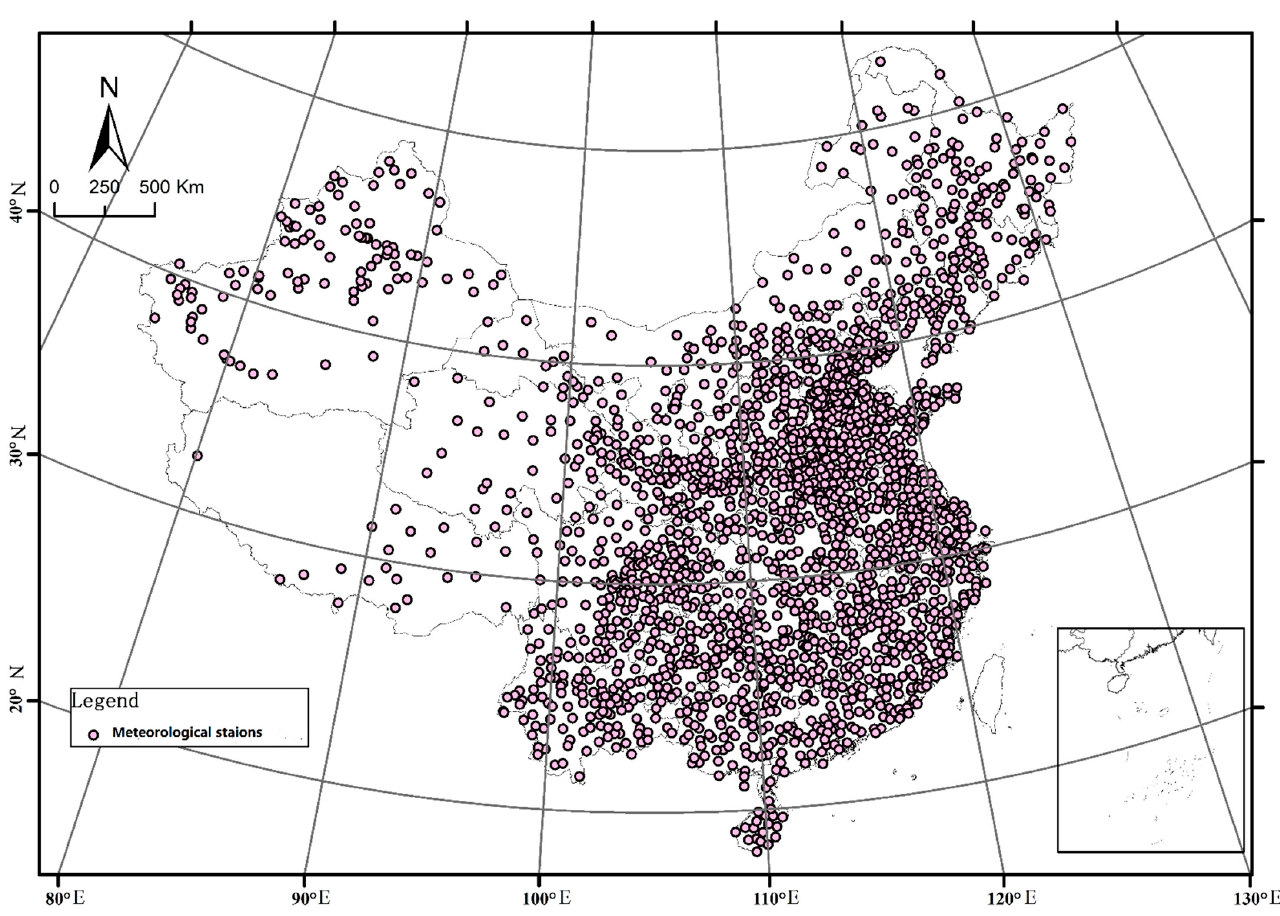
Figure 1. Meteorological stations of China.